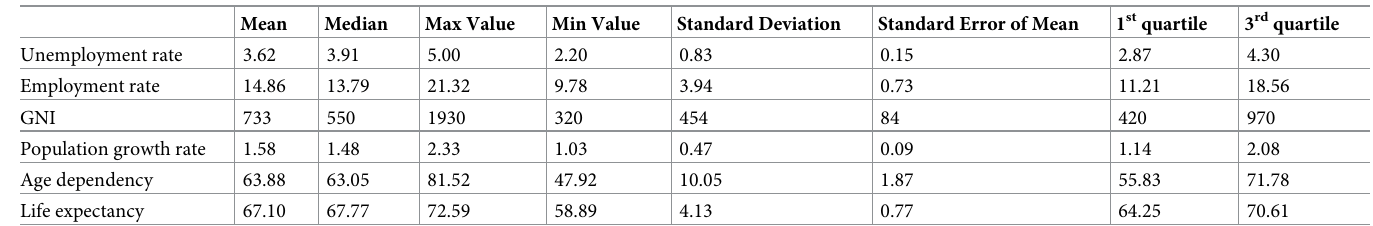
Table 2. Descriptive statistics for predictor and response